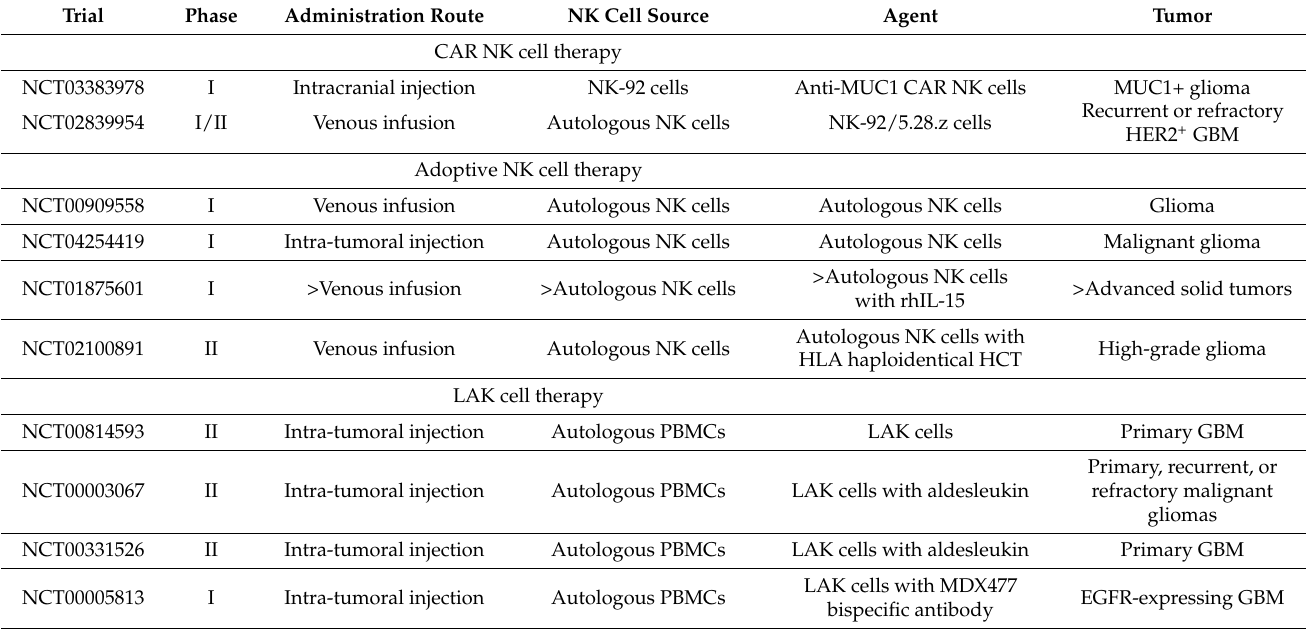
Table 1. Active clinical trials of NK cell-based immunotherapies against glioma.